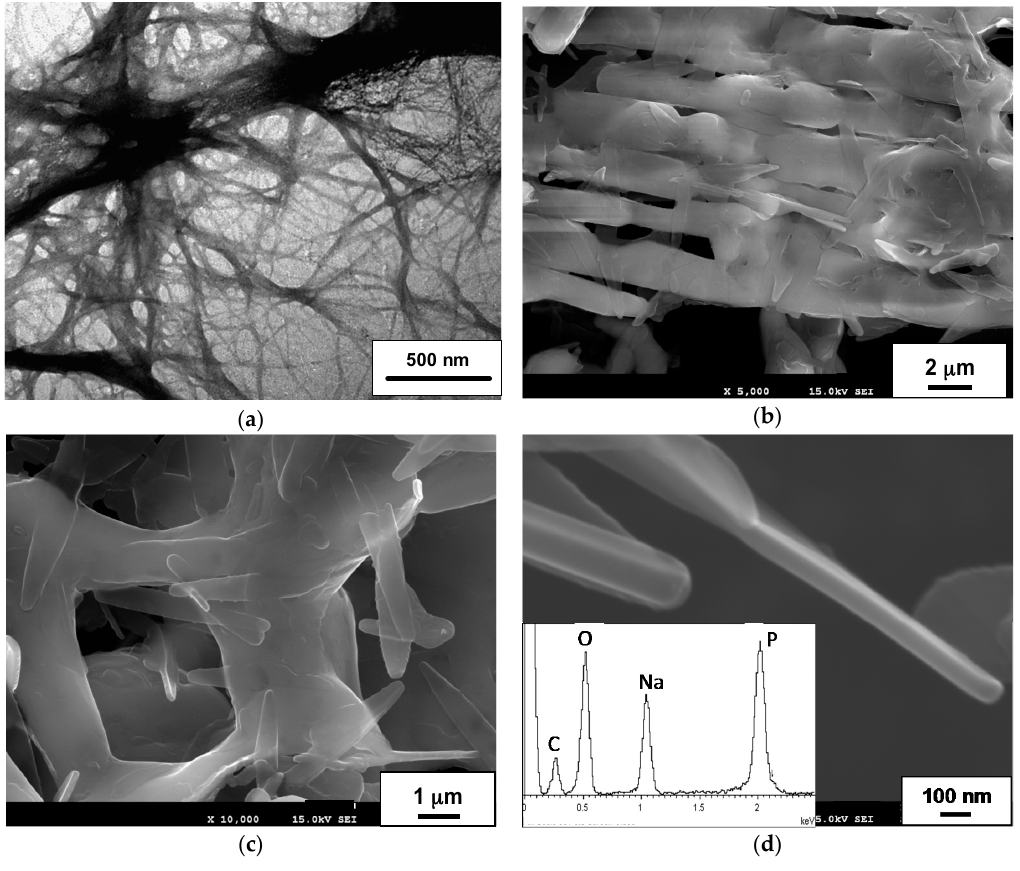
Figure 1. ( a ) TEM image of HCl-C12GA hydrogel (Pt-shadowing) formed in aqueous acidic medium (HCl vapors); ( b – d ) SEM images of H 3 PO 4 -C12GA hydrogel in aqueous NaH 2 PO 4 medium (lyophilized xerogel). The inset in ( d ) shows a representative EDX spectrum of the NaH 2 PO 4 -containing C12GA xerogel (average P/Na molar ratio = 1.19 ± 0.07).